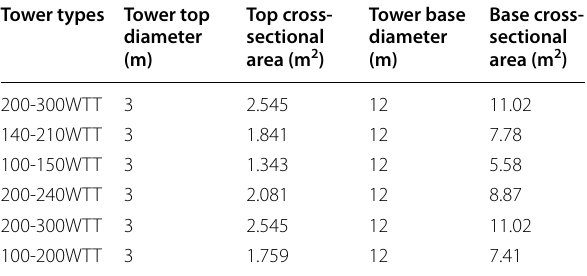
Table 4 Geometric properties of the tower section. Tower types Tower top